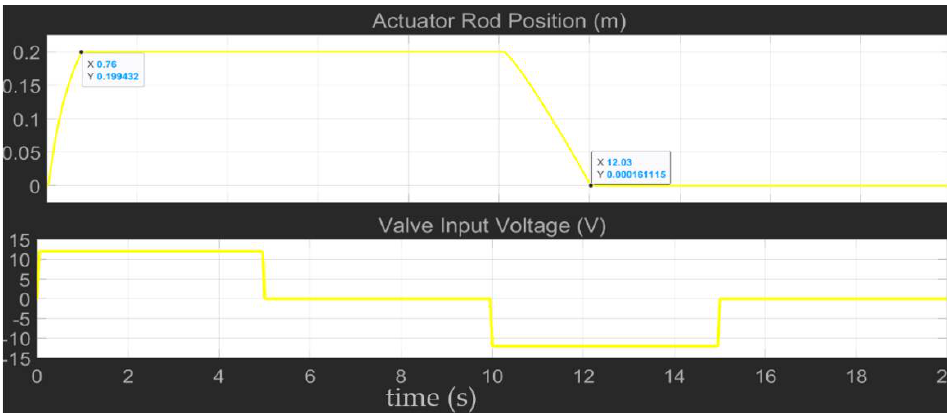
Figure 8. Effect of the valve’s input voltage on the rod’s displacement.